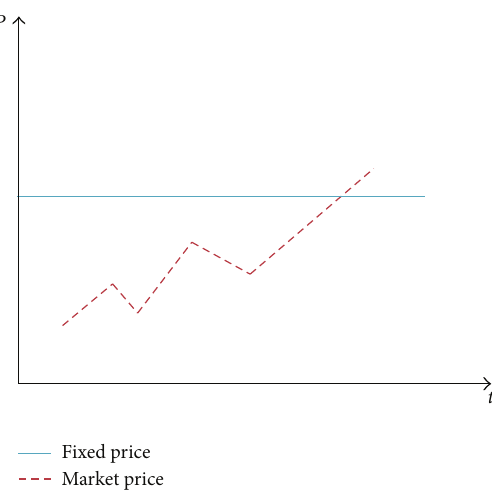
Figure 1: Fixed price model for FIT policy